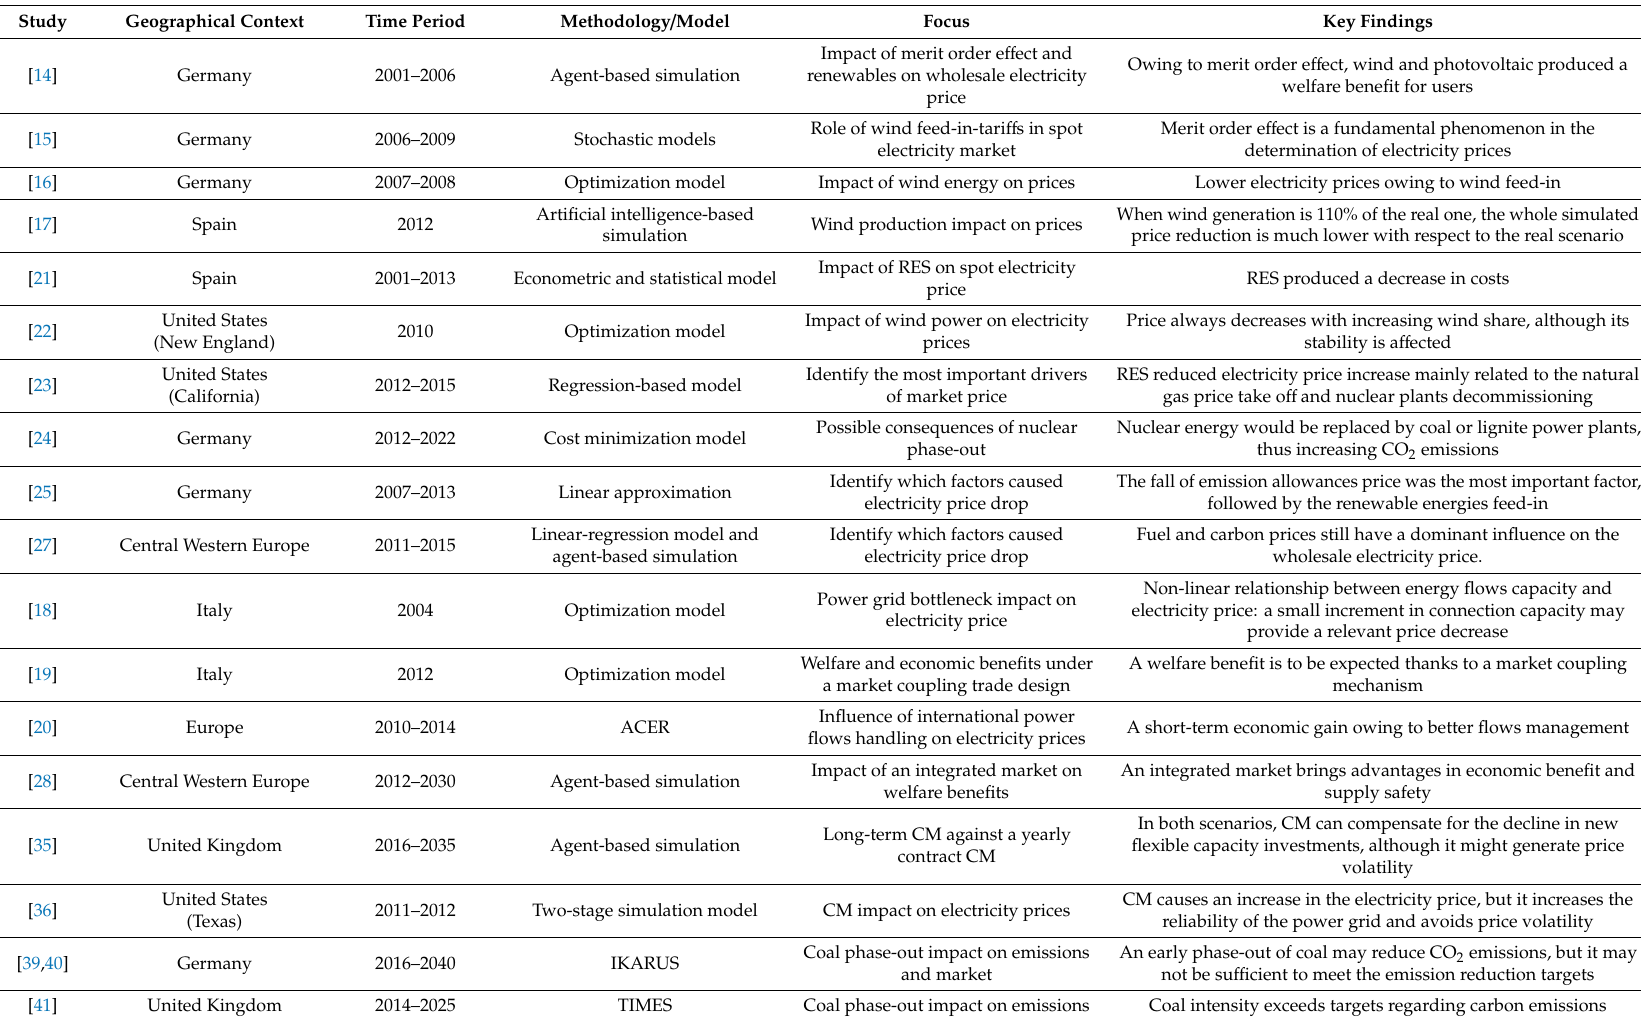
Table 1. Recap of the literature review. RES, renewable energy source; CM, capacity